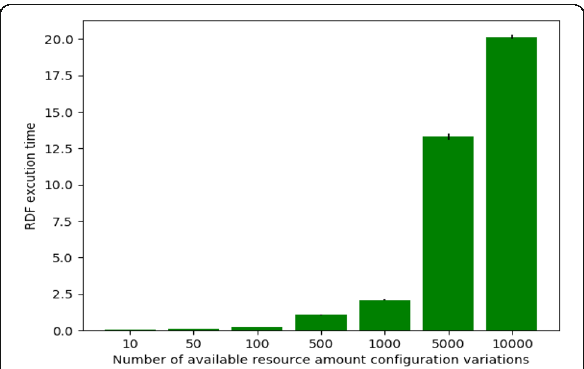
Fig. 11 RDF execution time for different numbers of resource amount variations